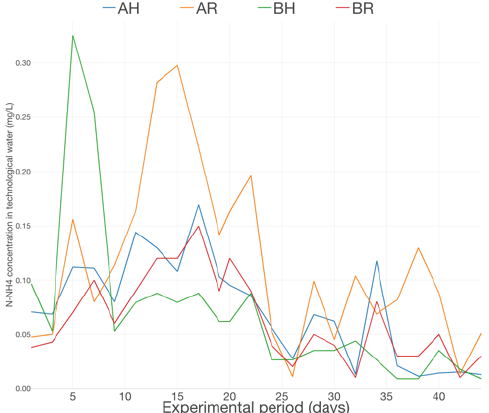
Figure 17. The dynamics of N-NH 4 concentration in technological water for each of the experimental variants.